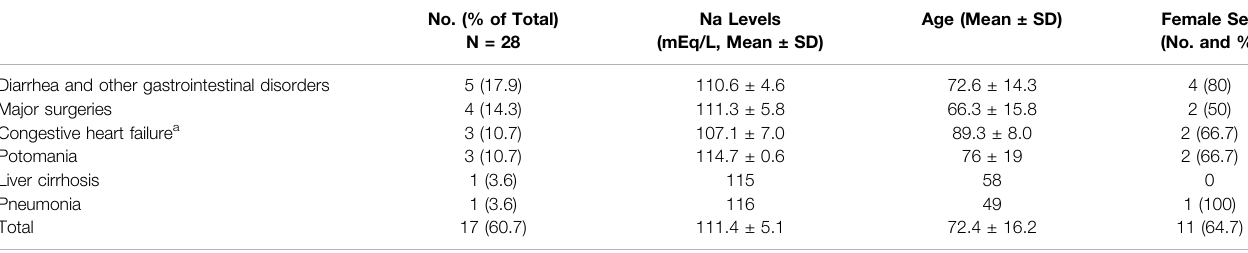
TABLE 3 | Patients with hyponatremia who met exclusion factors due to underlying diseases that explained the analytical